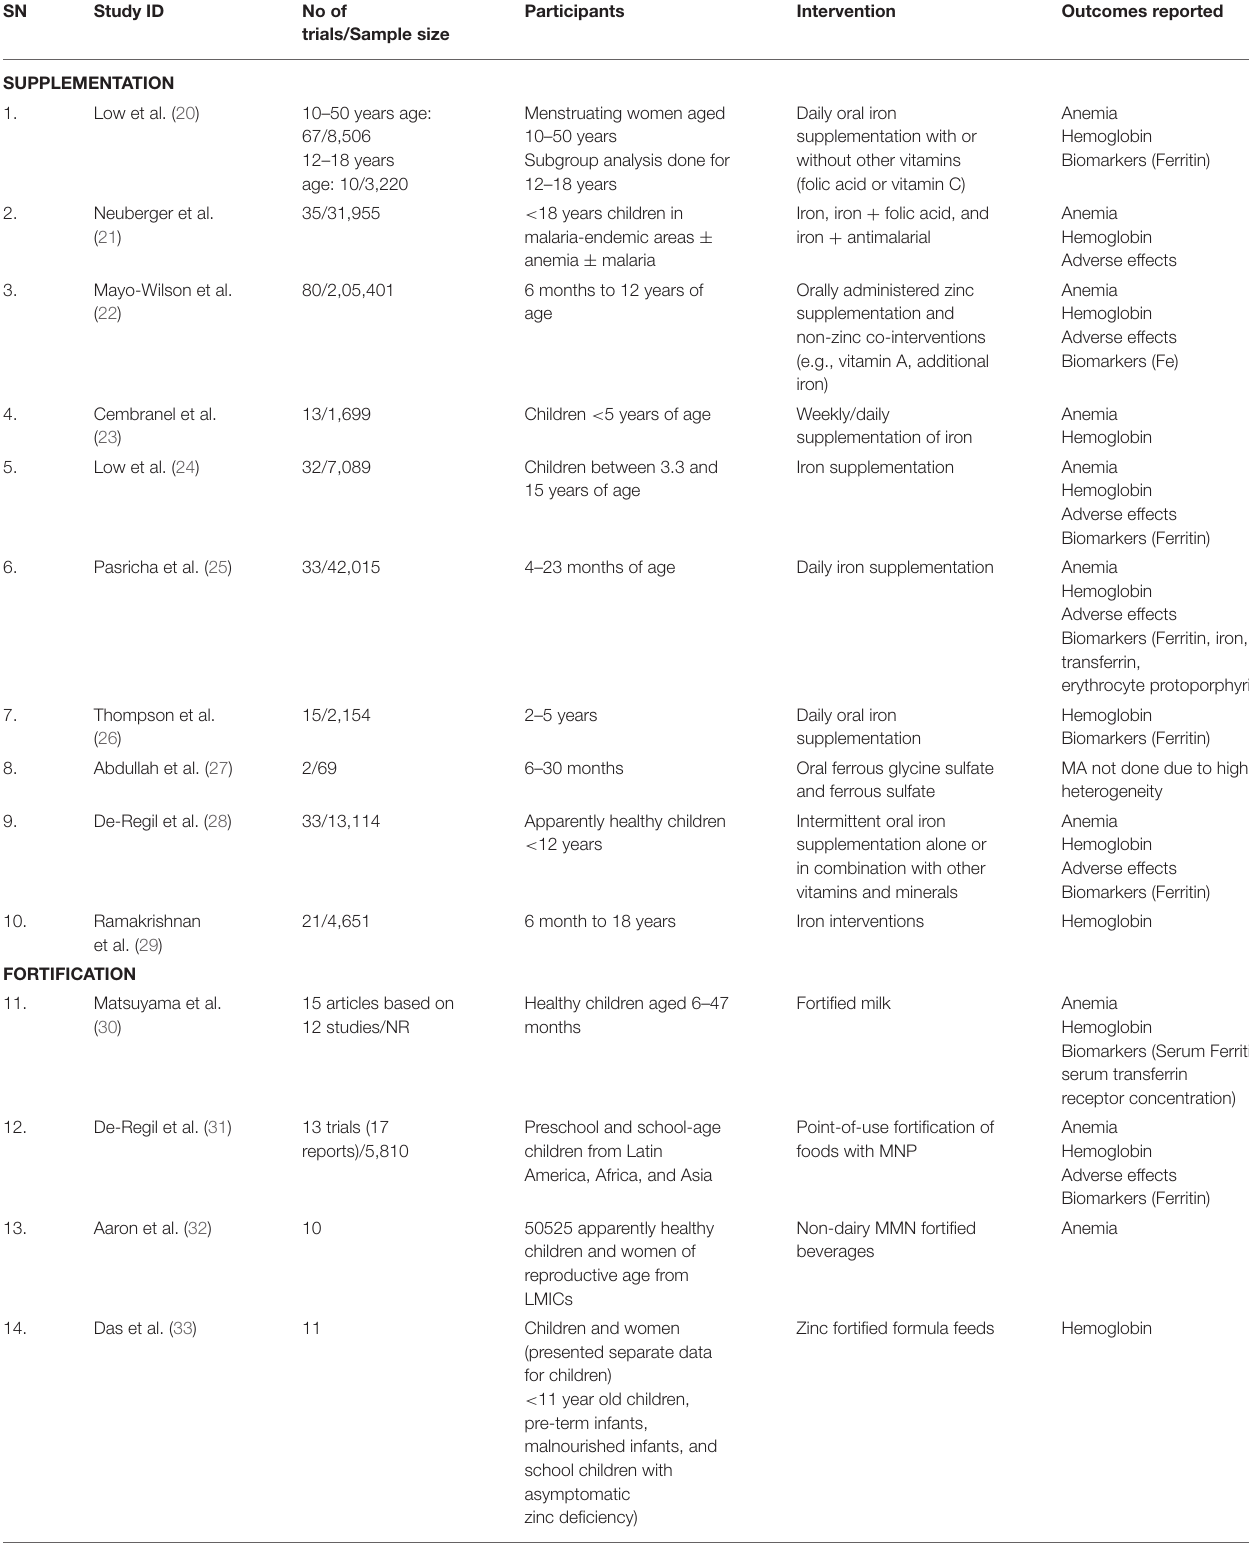
TABLE 1 | Characteristics of the included systematic